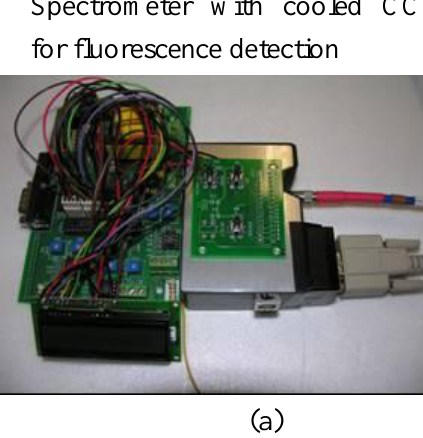
Figure 5. System integration of the PCR vessel chip, heater chip and fluorescence detector. Spectrometer with cooled CCD for fluorescence detection